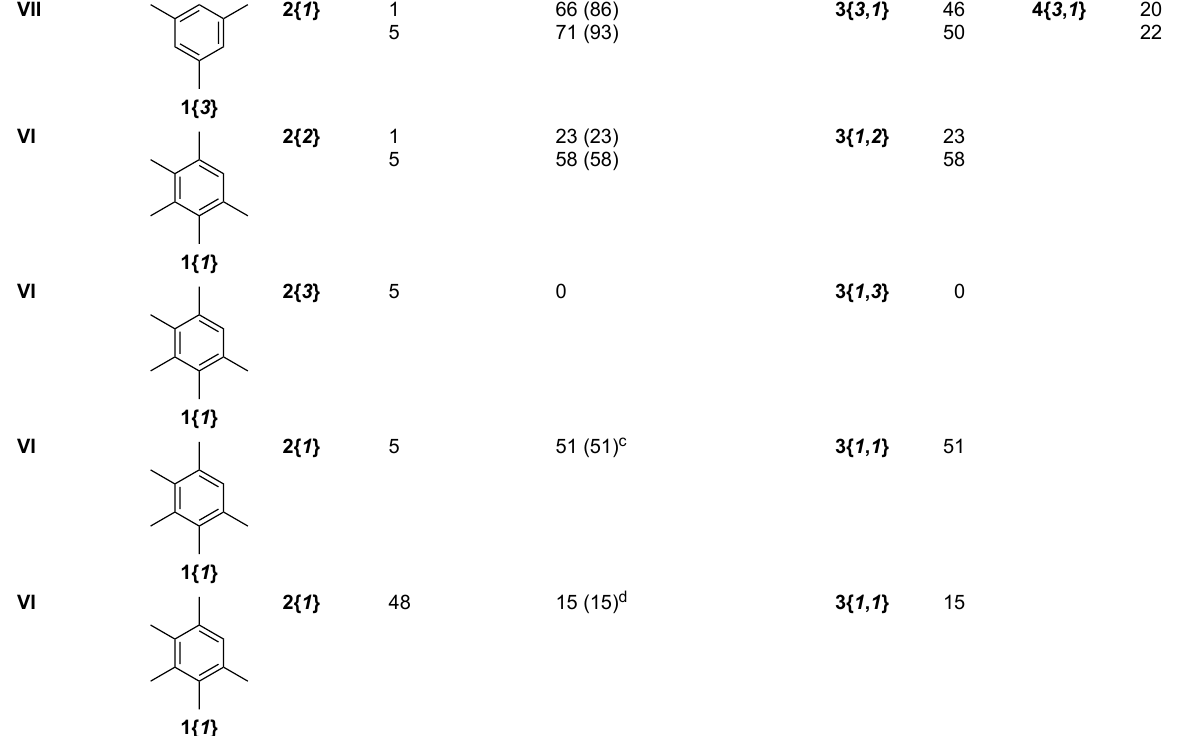
Table 1: Hydroarylation of alkynes using gold NHC catalysts: screening of different arenes and alkynes. a (continued)